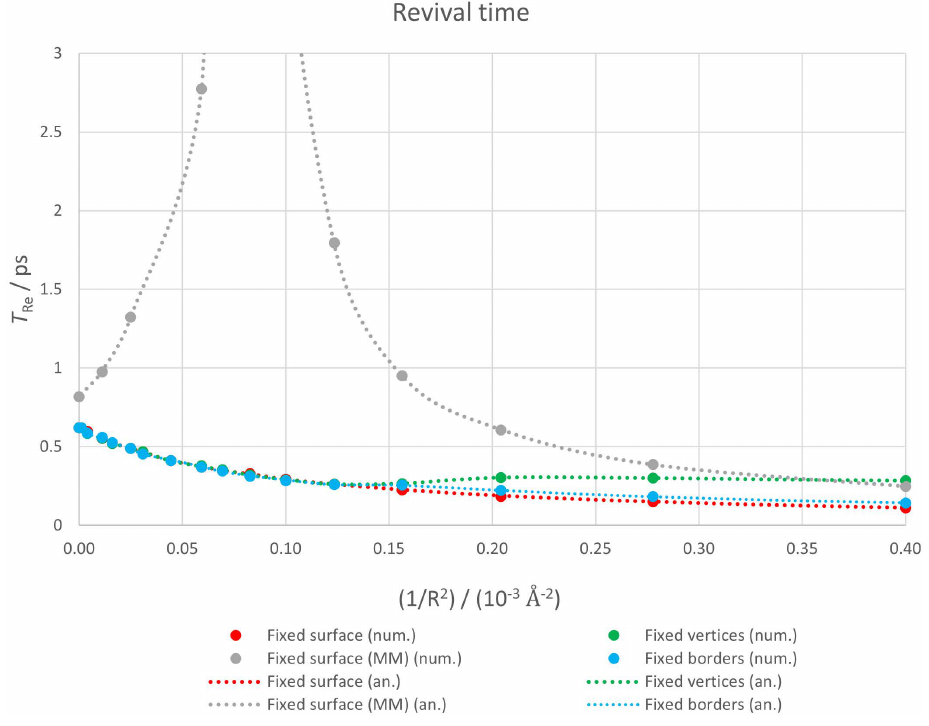
Figure 8. Revival times for a curved graphene nanoflake. Points correspond to numerical values while dotted lines represent analytical